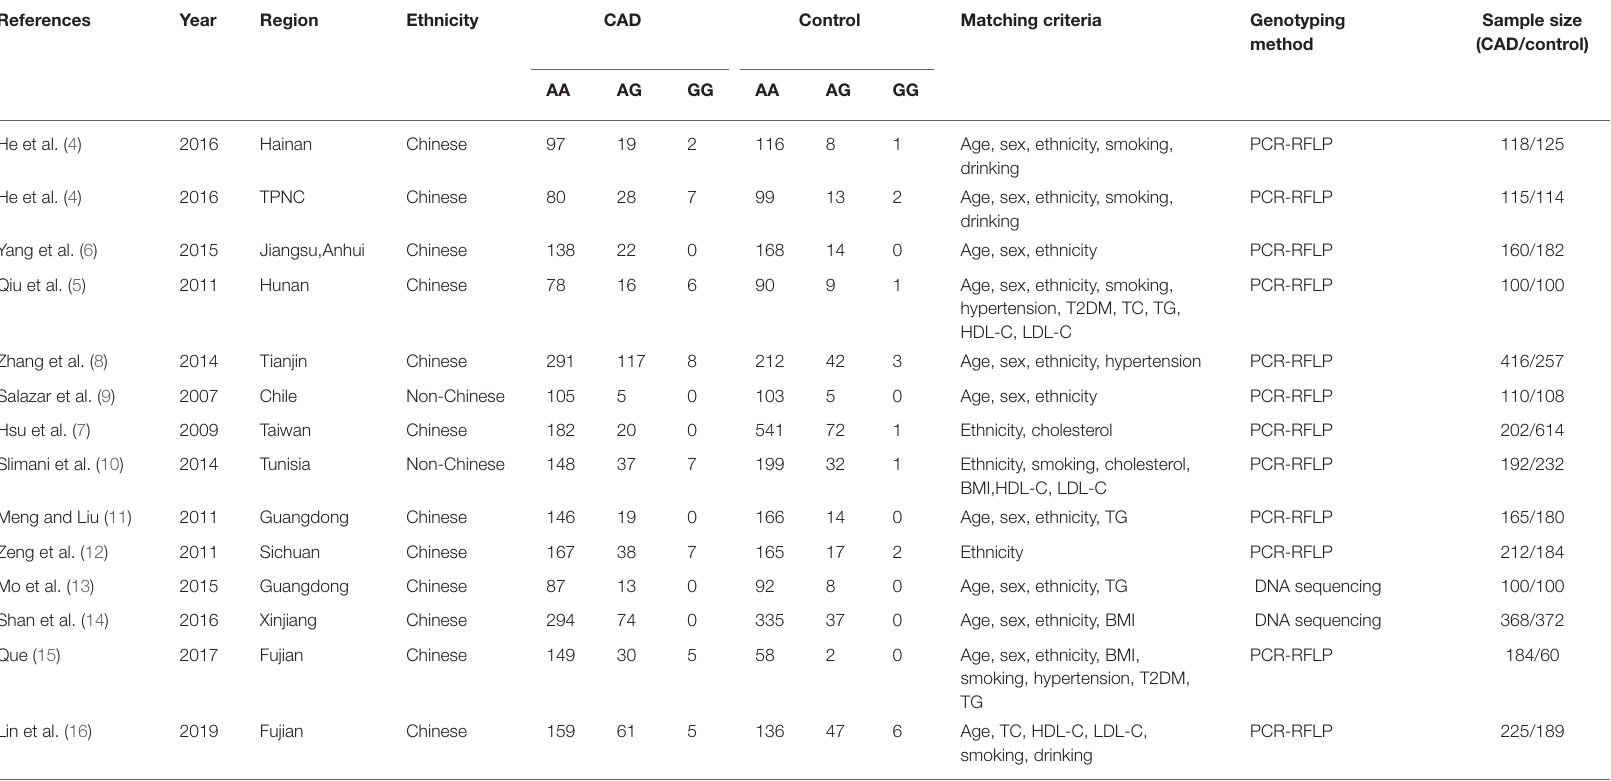
TABLE 1 | Characteristics of the investigated studies of the association between the PCSK9 gene E670G (rs505151) polymorphism and